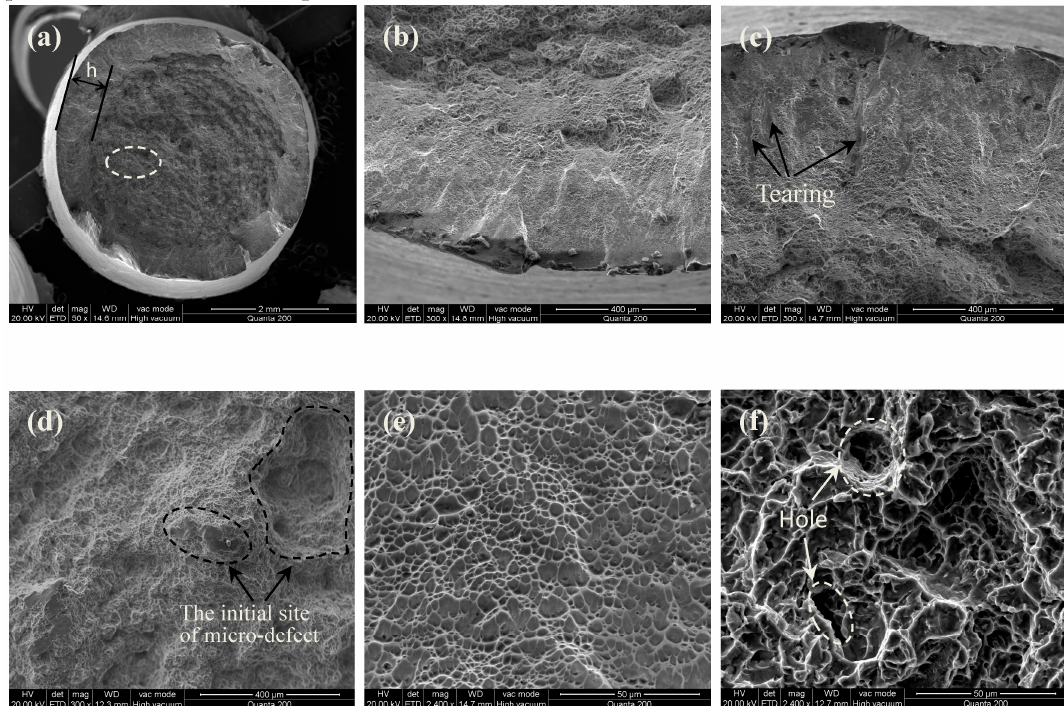
Figure 9. Tensile fracture morphologies of the MUSR-treated sample: ( a ) 50×; ( b ) cleavage; ( c ) tearing; ( d ) the crack initial site (white region in (a)); ( e ) dimples in the surface modification layer; ( f ) dimples and holes in the inner material substrate.